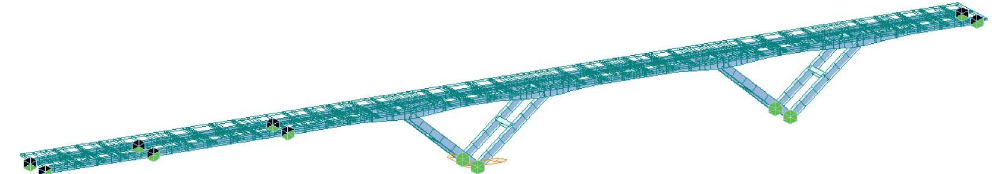
Figure 5: FEM model of the bridge.